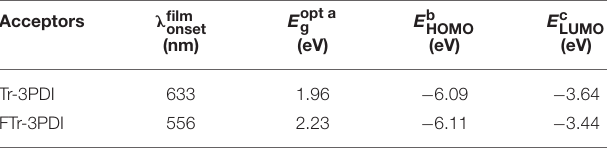
TABLE 1 | Optical and electrochemical properties of Tr-3PDI and